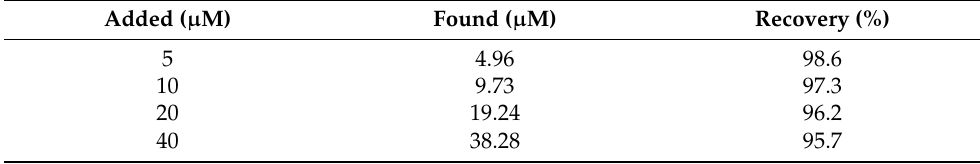
Table 2. Determination of L-Dopa in the “Madopar” tablet sample at Eu 2 O 3 @Cr 2 O 3 modified